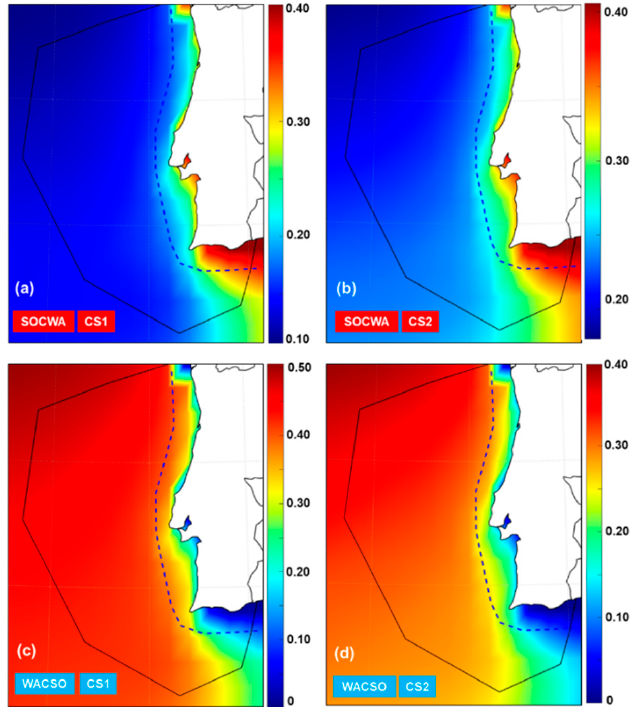
Figure 7. Spatial maps illustrating: ( a , b ) solar-wave power complementarity (SOCWA)—case studies 1 and 2, respectively; ( c , d ) wave-solar complementarity (WACSO)—case studies 1 and 2, respectively.